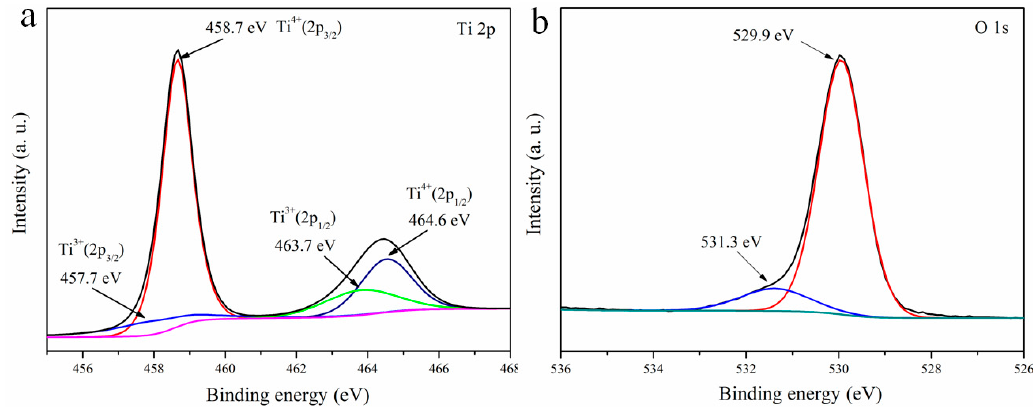
Figure 4. XPS spectra of the branched TiO 2 NRAs: ( a ) Ti 2p; ( b ) O 1s.